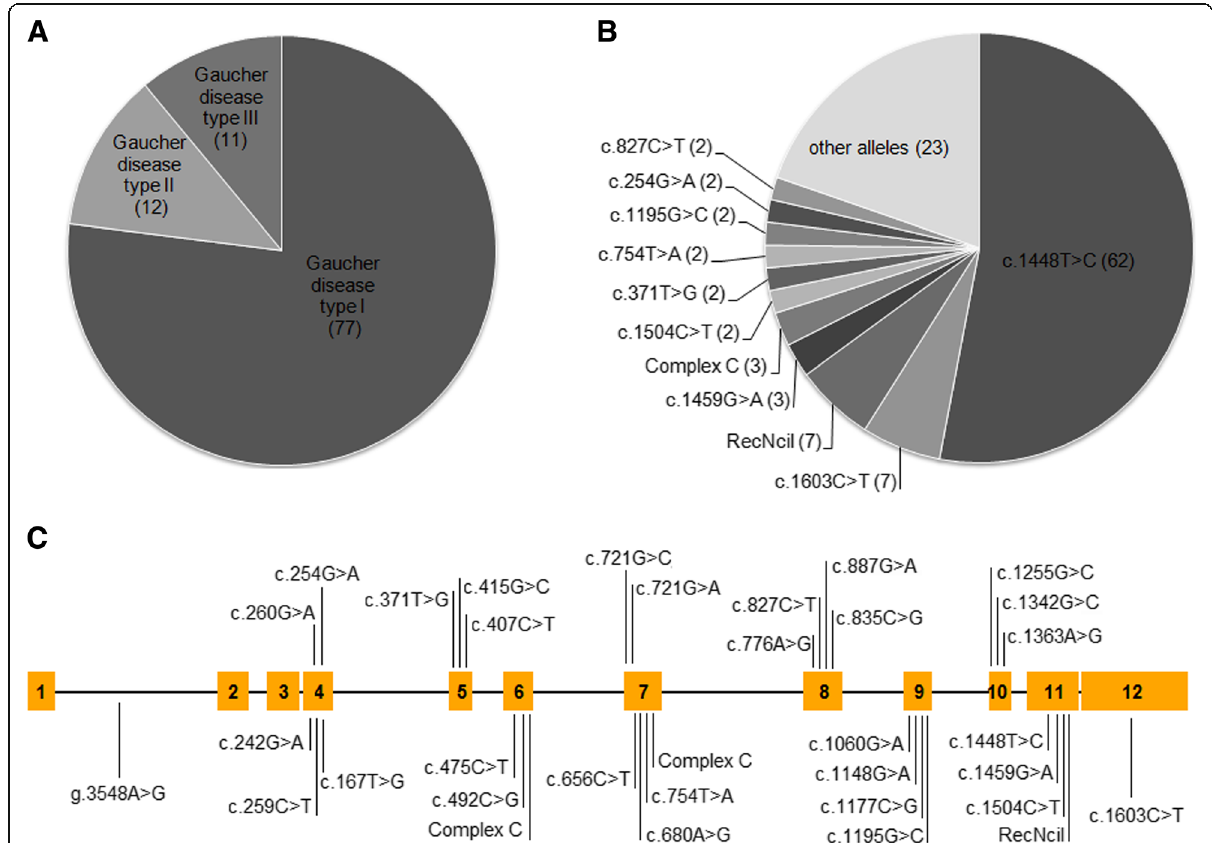
Fig. 1 Illustrative representation of the distributions of the variants identified in Indian Gaucher patients investigated in this study. a Majority of the patients were affected with Gaucher disease type I (77 patients), followed by Gaucher disease type II (12 patients) and Gaucher disease type III (11 patients). b The most common mutation c.1448T>C was observed in 62 patients (including homozygotes and compound heterozygotes). The second most common mutations identified were c.1603C>T and RecNcil. c Variations on exon 4 – 12 were observed on GBA1 gene. Also a mutation g.3548A>G was observed in the intron 1. The mutations were more clustered on exon 4 and exon 7 to exon